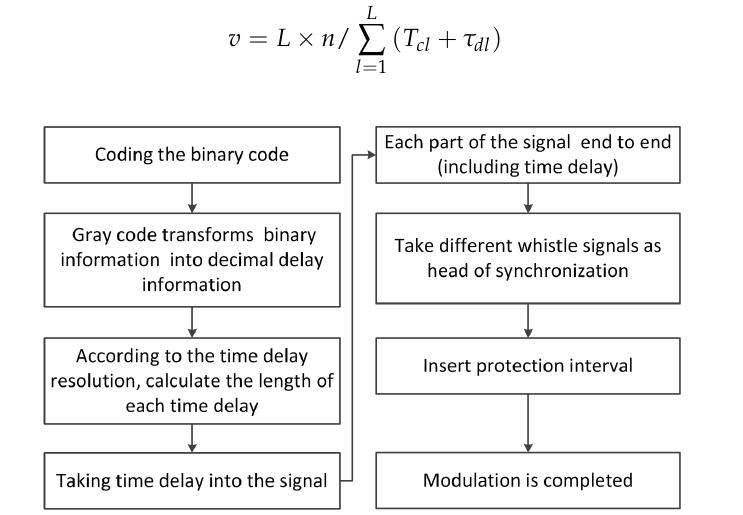
Figure 8. Process flow chart of bio-signal modulation.